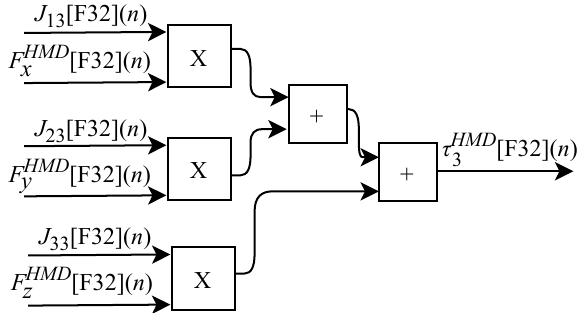
[ F 32 ]( n ) joint (Equation 3